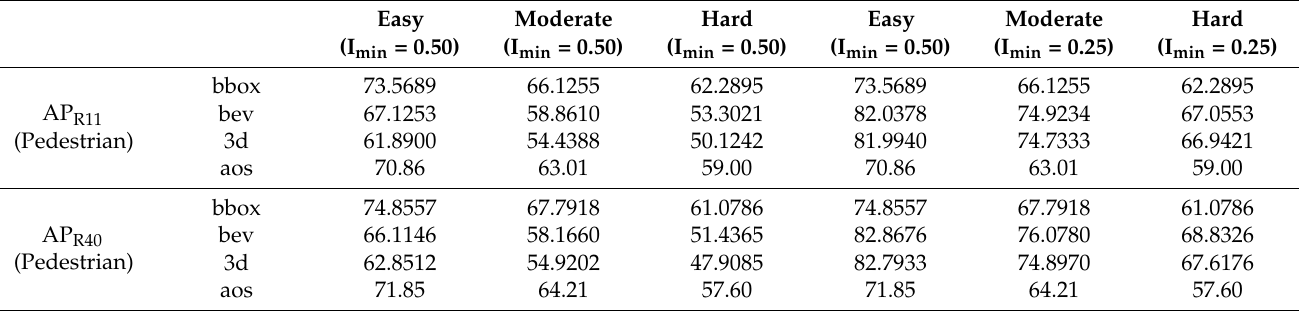
Table 3. The Performance of PointRCNN in the pedestrian class of KITTI with different IoU.